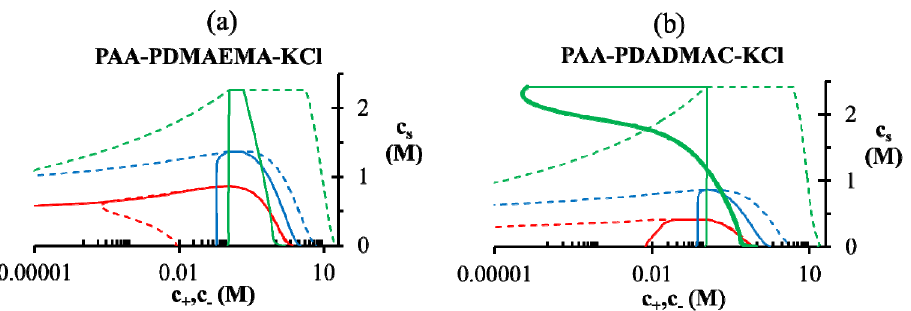
Figure 5. Binodal compositions of polyelectrolytes in ( a ) PAA -PDMAEMA -KCl and 597 526 -PDADMAC -KCl systems. The y -axes shows the total added salt ( b ) PAA 597 557 concentration and the x -axis shows the concentrations of PAA ( (cid:1855) ) and (cid:2879) PDMAEMA/PDAMAC ( (cid:1855) ) in the supernatant and dense phase. Dashed and bold lines (cid:2878) represent concentrations of PAA and PDMAEMA/PDADMAC, respectively. pH values are pH = 4 (green), pH = 5 (blue), and pH = 7 (red). Polyion concentration in the supernatant and dense phases are given by the left and right arm of the binodal, respectively, except for pH = 4 in ( b ), where the PDADMAC concentration in the supernatant and dense phases are represented using the thin and thick section of the bold ((cid:1842)(cid:1827)(cid:1827)) = 0.75 in both the line, respectively. (cid:2031) (cid:2879)(cid:3050)